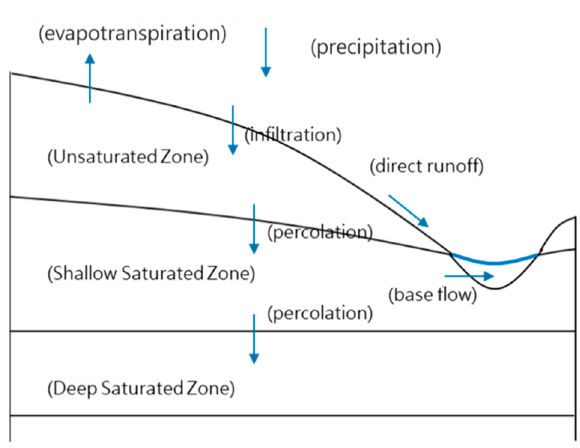
Figure 4. Concept of GWLF water balance model (made by this study). The parameters required by the GWLF include the area and the land use (represented by the CN value) of the watershed which is shown as Table 3. Table 3. Parameters of GWLF in the watershed of Zengwen